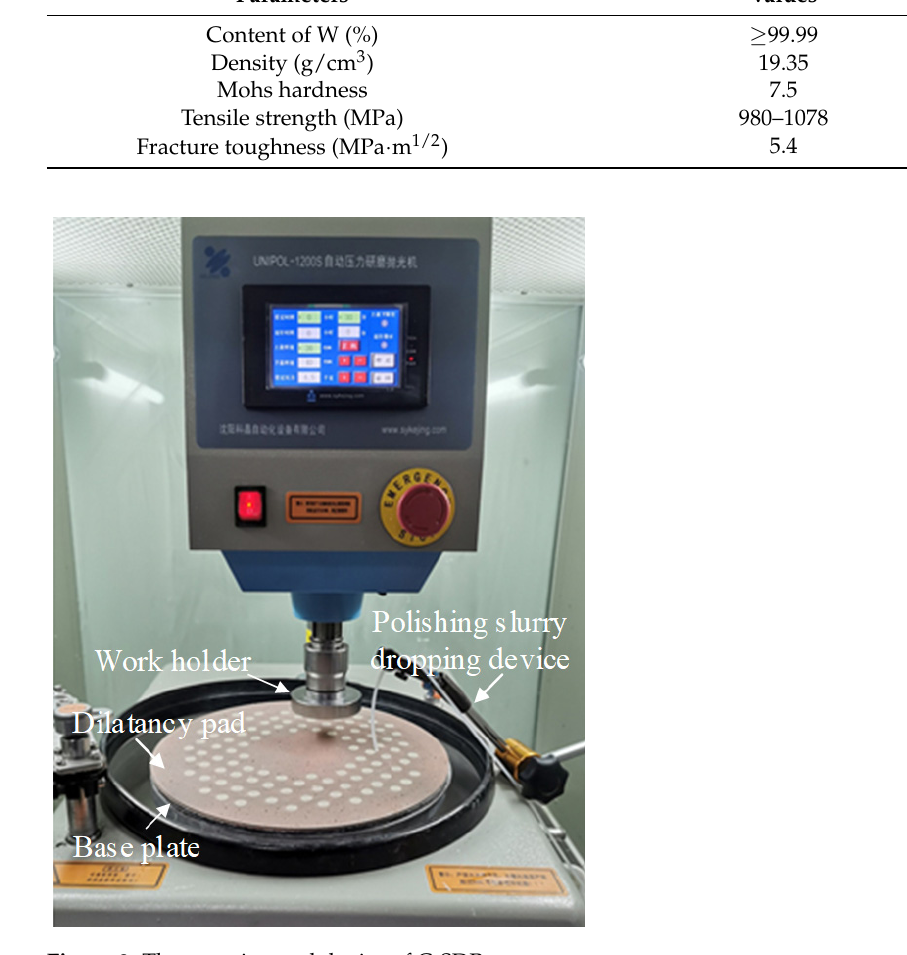
Figure 3. The experimental device of C ‐ SDP.